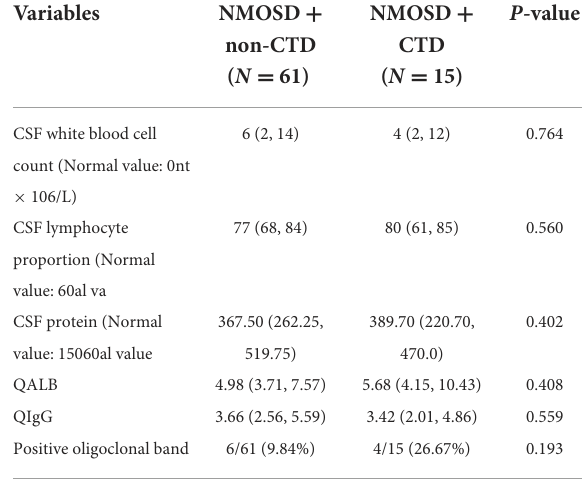
TABLE 2 Demographic and clinical characteristics in patients of first-attack NMOSD with and without CTD.